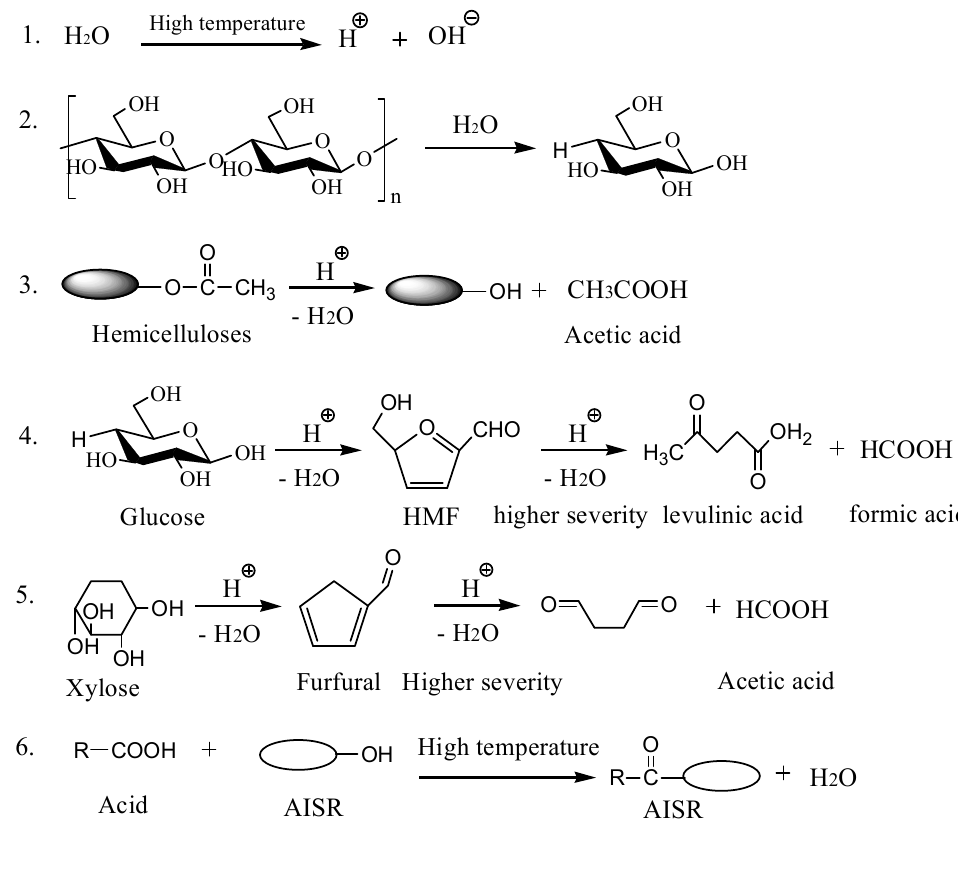
Scheme 1. Mechanisms for the formation of carbonyl groups in